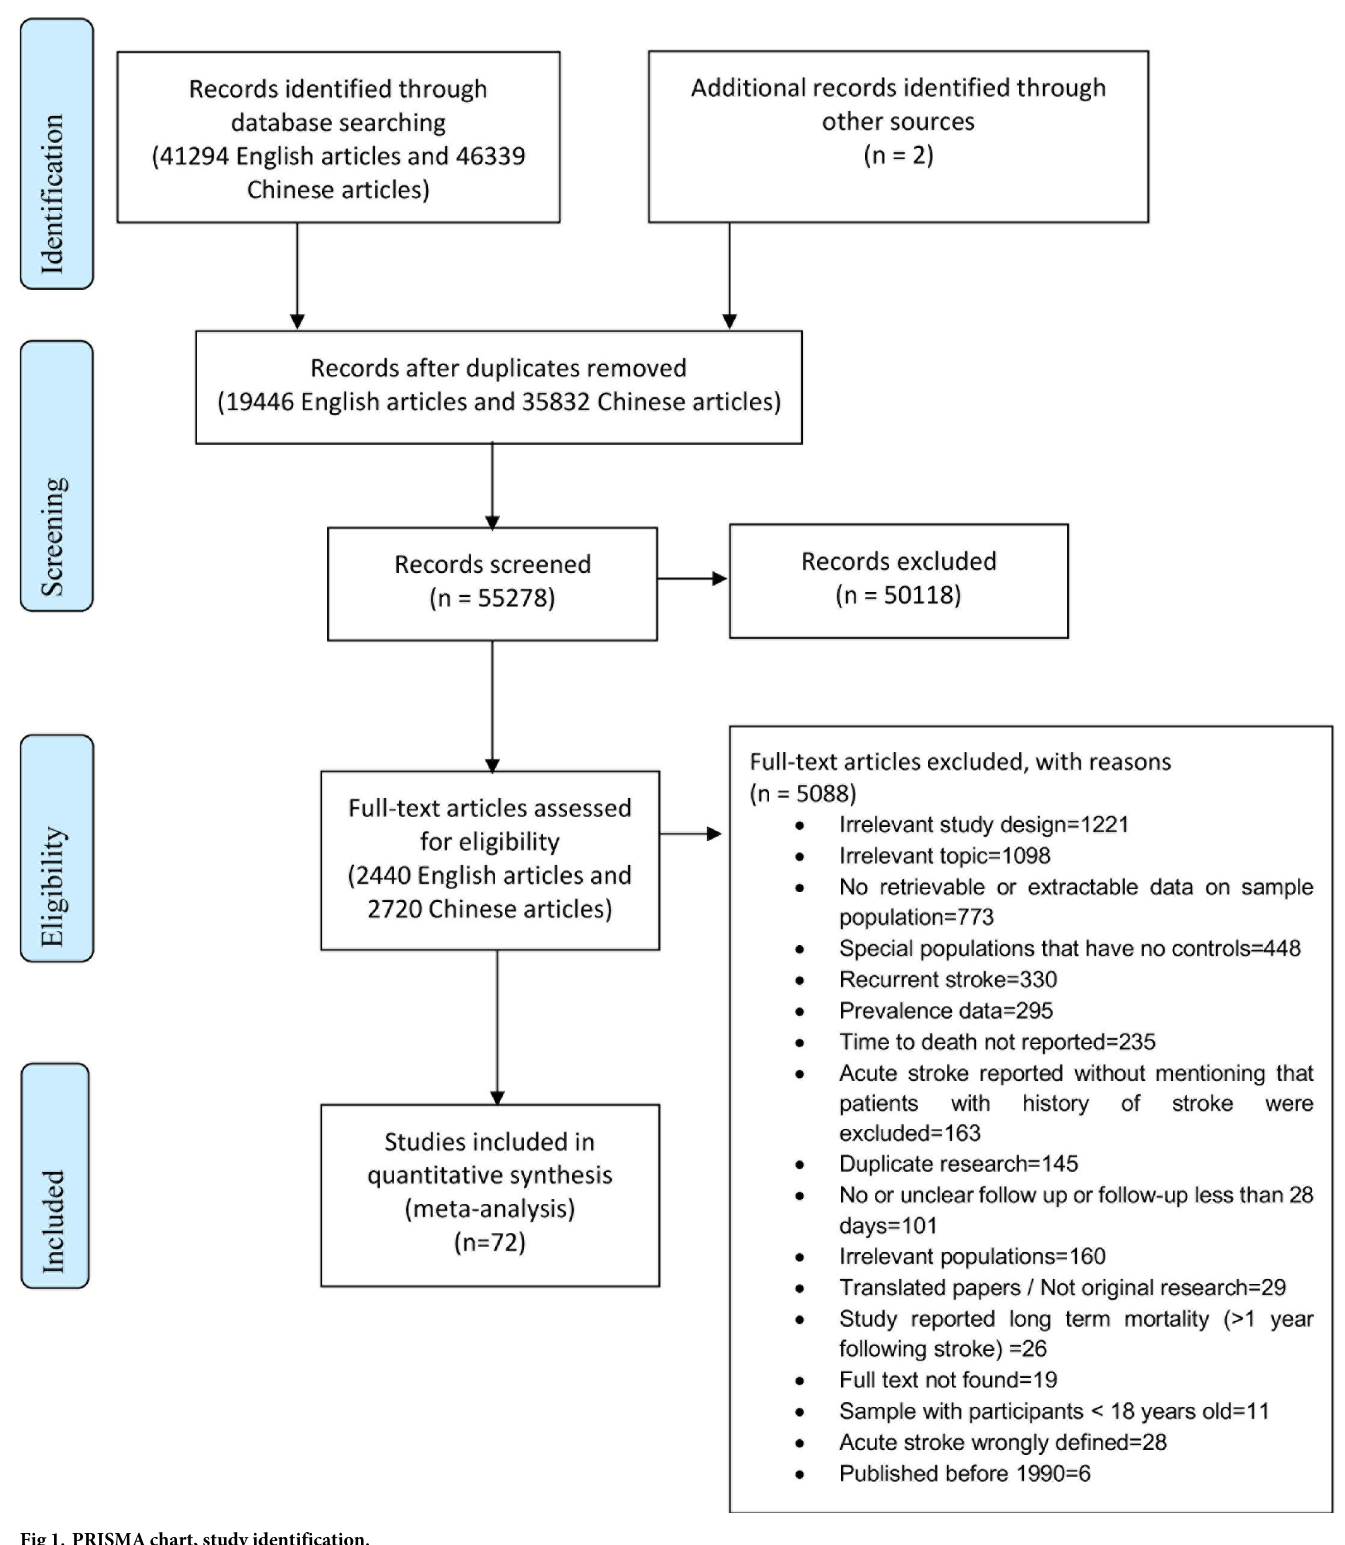
Fig 1. PRISMA chart, study identification.